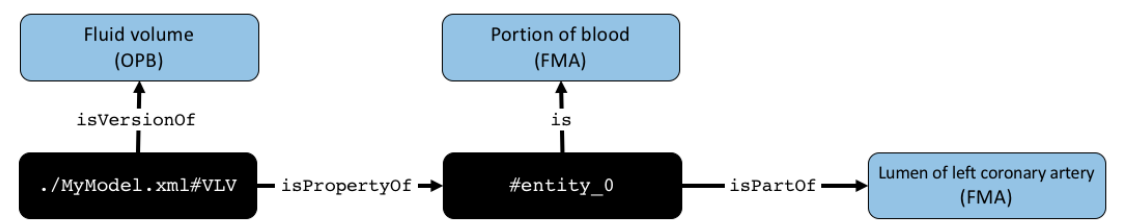
Figure 1. Node and edge representation of an example composite annotation for a model variable that simulates blood volume in the left coronary artery. RDF resources local to the OMEX metadata file are in black boxes, external knowledge resource terms are in blue